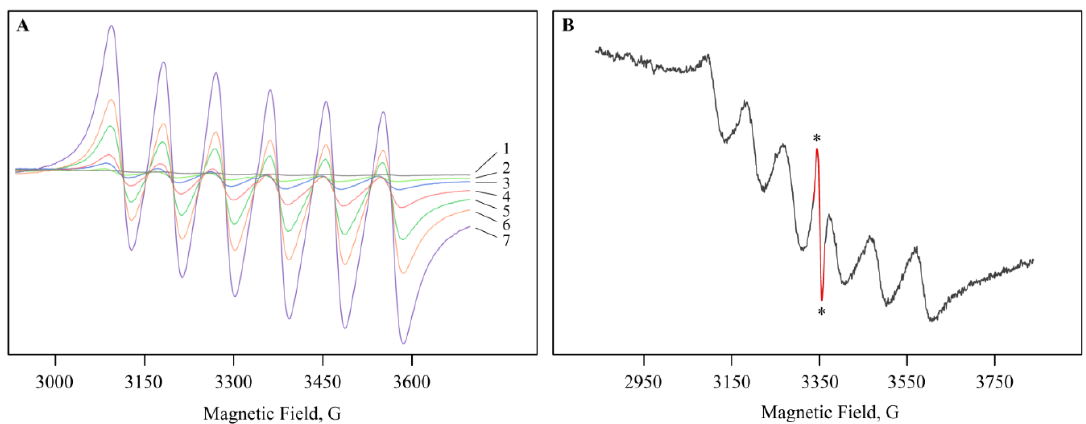
Figure 1. The EPR spectra in leaves with ( A ) and without ( B ) Mn sulfate in the nutrient medium. ( A ): (1)—0 mol/L, (2)—0.1 mol/L (control), (3)—0.2 mol/L, (4)—0.5 mol/L, (5)—1 mol/L, (6)—2 mol/L, (7)—10 mol/L. ( B ): the additional line is indicated by the asterisks.